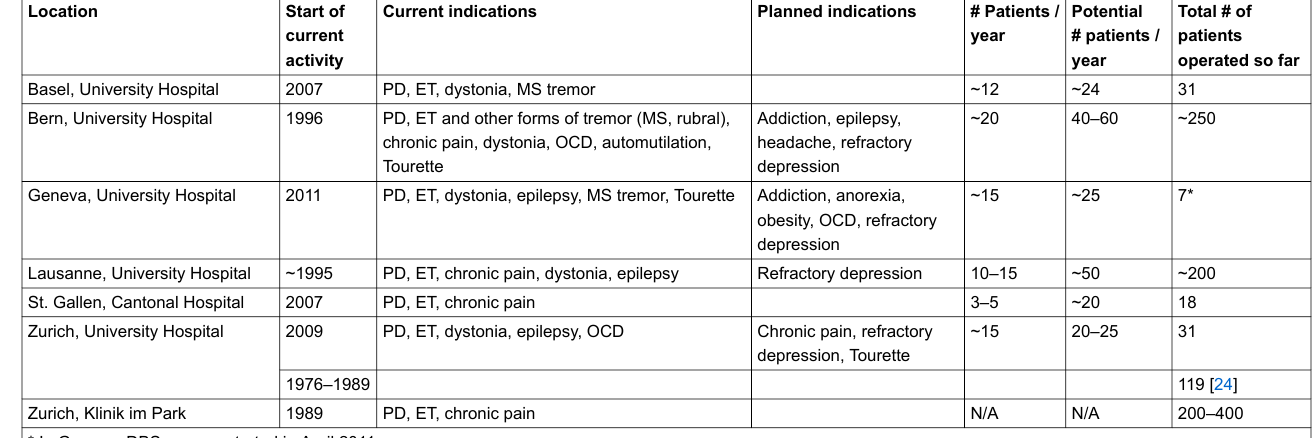
Table 1: An overview of Swiss DBS centers which are currently operative. The column “start of current activity” refers to the year in which the first patient has been operated at the center. The data reflect the situation by end of 2011.